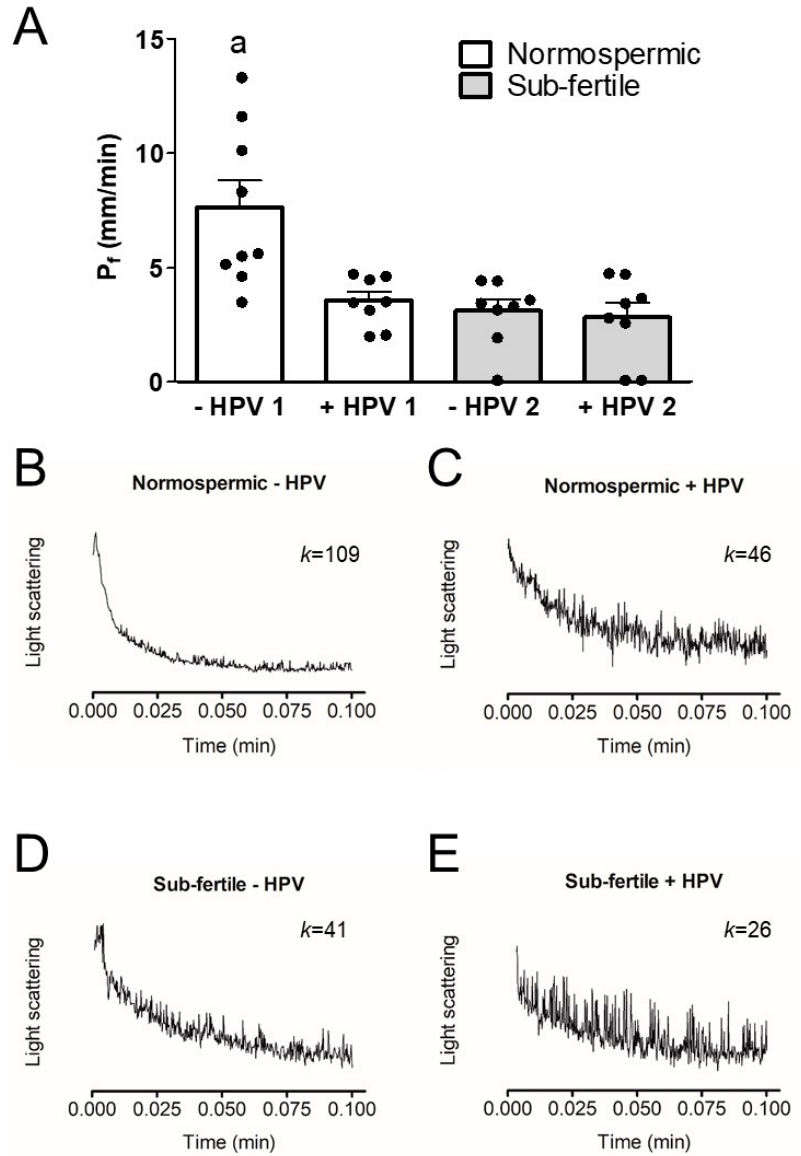
Figure 1. Osmotic water permeability of human ejaculated semen from normospermic (1) and sub-fertile (2) subjects with ( + HPV) and without ( − HPV) HPV infection. The osmotic water permeability was measured by exposing sperm cells to a 150 mOsm osmotic gradient and expressed as Pf (see Materials and methods). ( A ) Bars represent means ± SEM of 4–15 single shots for each of 8–10 di ff erent experiments; the individual data points are also shown (bullet point). a, p < 0.05 vs. normospermic HPV-positive, sub-fertile HPV-negative and sub-fertile HPV-positive (Kruskal–Wallis followed by Dunn’s Multiple Comparison Test). ( B – E ) Representative traces of stopped-flow osmotic water permeability measurements obtained from ejaculated semen of normospermic ( B , C ) and sub-fertile ( D , E ) subjects with ( C , E ) and without ( B , D ) HPV. K relative values of single curves are also